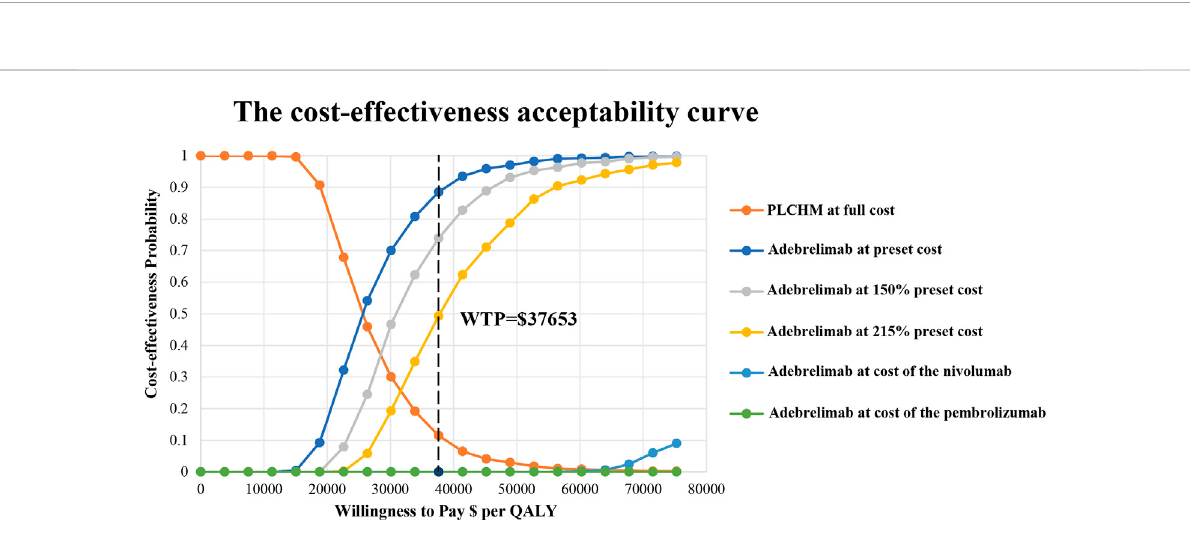
FIGURE 4 The cost-effectiveness acceptability curves for the ADCHM treatment option compared with the PLCHM treatment option. ADCHM: adebrelimab in combination with chemotherapy (etoposide-carboplatin); PLCHM: placebo plus chemotherapy (etoposide-carboplatin); QALY, quality-adjusted life year; WTP: